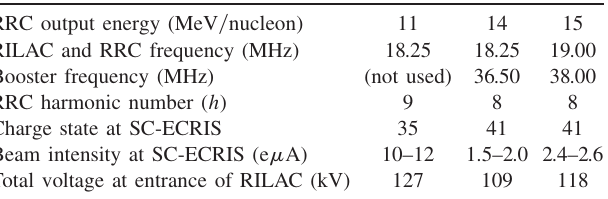
TABLE I. Parameters of acceleration modes of uranium beams.